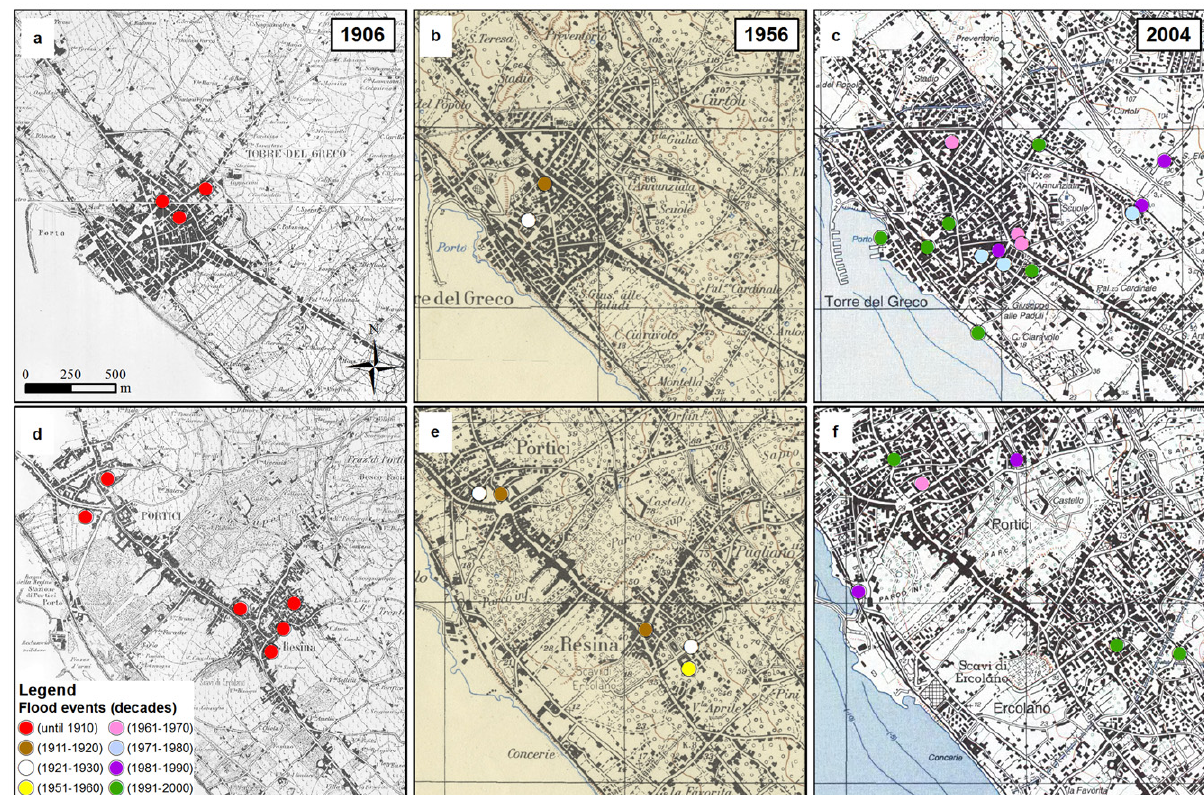
Figure 12. Urbanization variations in the last 100 years; the dots indicate the flood events for different decades; it is evident that many in- undations events have hit areas not urbanized at the beginning of the century for Torre del Greco (a,b,c), Portici and Ercolano